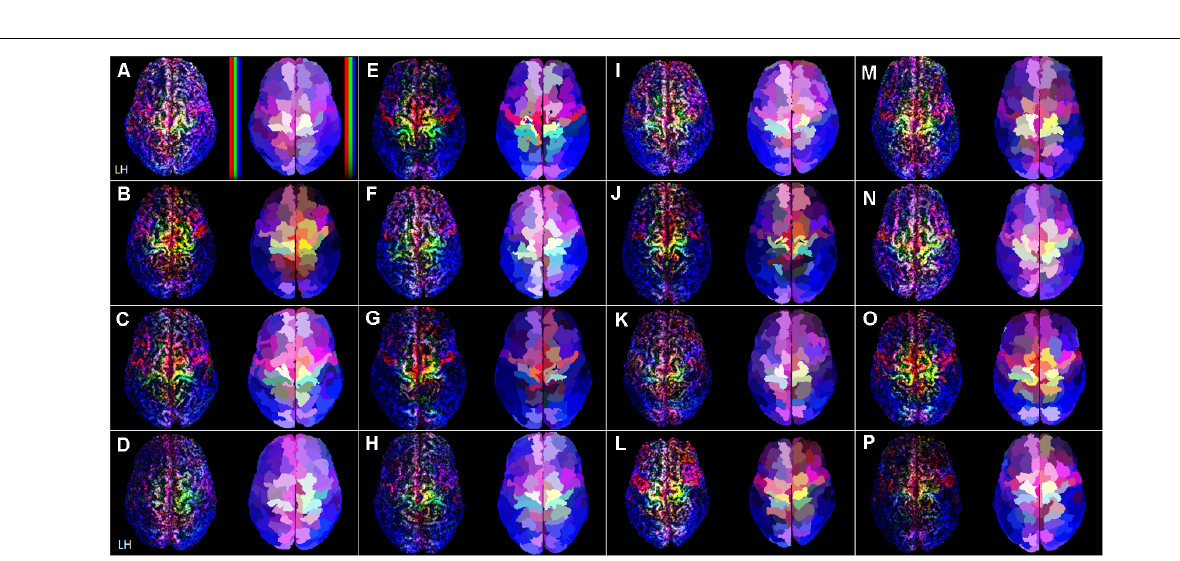
from the remaining 16 case datasets, voxel-based mean-TDRM in the surface area and parcellation-piece-based